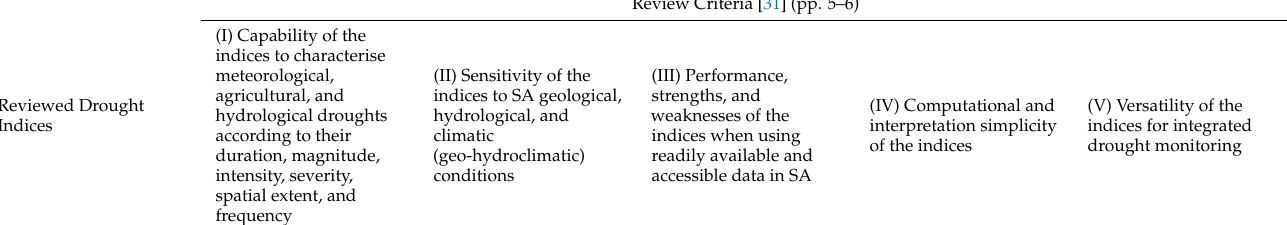
Table 5. Review of the SSI; based on the 2016 WMO Handbook of Drought Indicators and Indices [31] (pp.